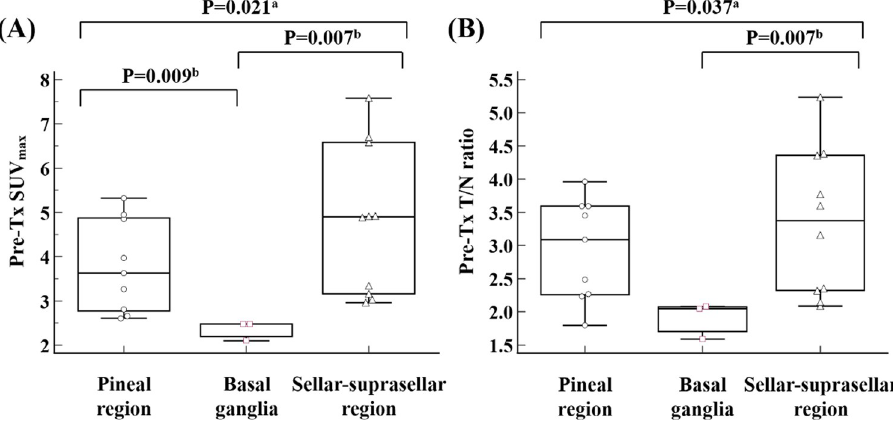
Fig 3. Comparisons of (A) pre-Tx SUV max and (B) pre-Tx T/N ratio between IGs located in pineal region, basal ganglia, and sellar-suparsellar region. Pre-Tx, pre-treatment; SUV max , maximum standardized uptake value; T/N, tumor-to-normal tissue, IG, intracranial germinoma. a According to Kruskal-Wallis test. b According to post hoc analysis using Mann-Whitney U test with Bonferroni’s method.